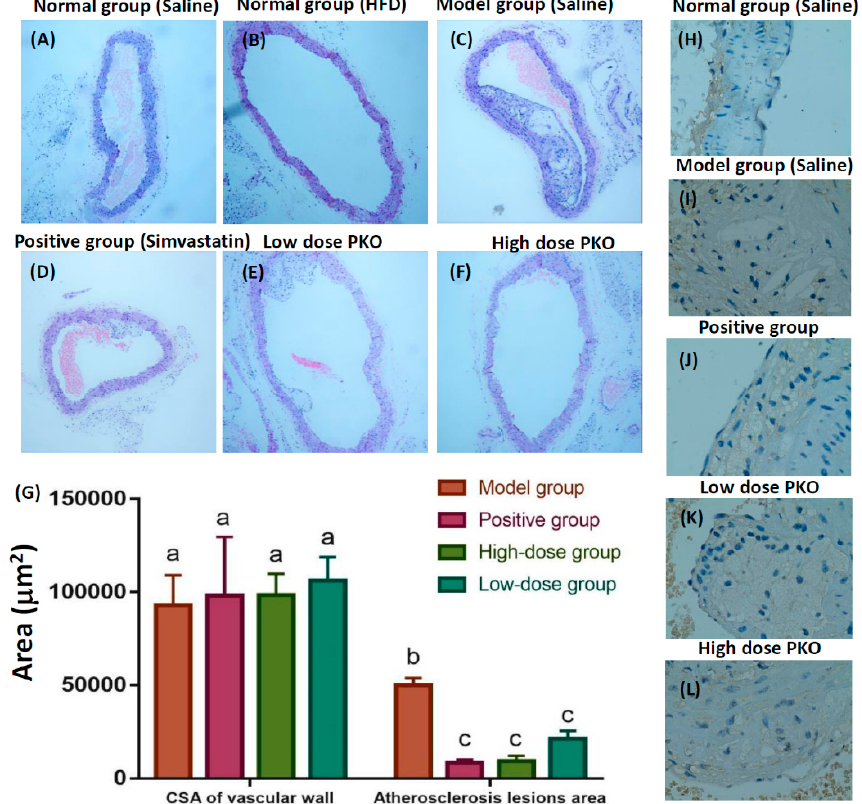
Figure 4. Histology and immunohistochemistry assay of the aorta of ApoE knockout (KO) mice at 400 × magnification after treating with peach kernel oil (PKO). ( A ) Normal aorta in normal mice without high-fat diet feeding (normal group); ( B ) Aorta in normal mice fed with high-fat diet feeding for eight weeks (normal group); ( C ) Aorta in ApoE KO mice fed with high-fat feeding for eight weeks (model group); ( D ) Aorta of ApoE KO mice fed with high-fat feeding and simvastatin (positive group); ( E ) Aorta of ApoE KO mice fed with high-fat feeding and high dose peach kernel oil (PKO); ( F ) Aorta of ApoE KO mice fed with high-fat feeding and low dose PKO ( G ) Quantitative results from lumen area (statistics was tested by One-way ANOVA and Tukey-HSD test, p < 0.01). Different labels above columns in ( G ) indicate a significant difference tested by One-way ANOVA between different experimental groups with p < 0.01. Immunohistochemistry assay showing TF protein expression level in atherosclerotic plaques in ( H ) normal group ( I ) model group ( J ) positive group ( K ) high dose PKO treatment and ( L ) low dose PKO treatment groups. Table 1. The comparison of aortic atherosclerotic lesions area in mice ( 𝑋(cid:3364) ± SD, n = 8). Grouping